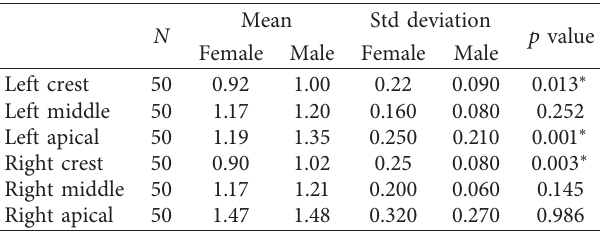
Figure 1: (a) Three locations for measuring alveolar bone thickness; (b) three sites for measuring buccal bone thickness. Table 1: Descriptive statistics of left and right buccal bone Table 3: T -test between left and right bone thickness (mm) for both thickness (mm) by gender with comparison of thickness between males and females by sites. males and females according to side using t -test.